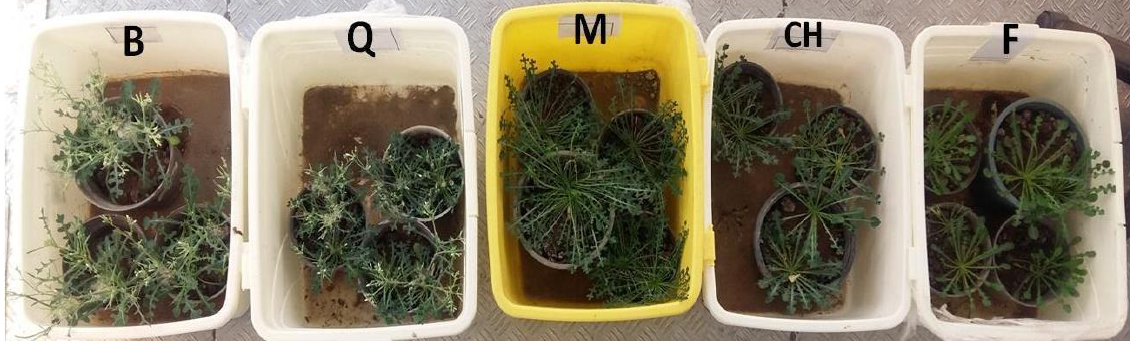
Fig. 3. Plants obtained from sowing seeds of five L. undulata populations: M) Mirzabayloo; F) Firoozkooh; B) Biarjmand; CH) Cheshmeh Ali; Q) Qom.